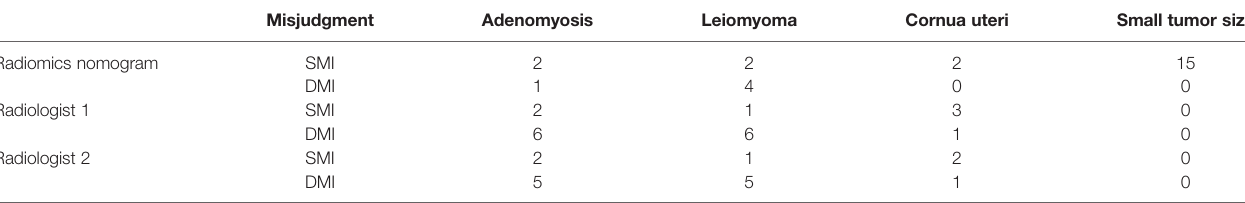
TABLE 3 | The certain cases of misjudgment with the reason in the radiomics nomogram and radiologists.